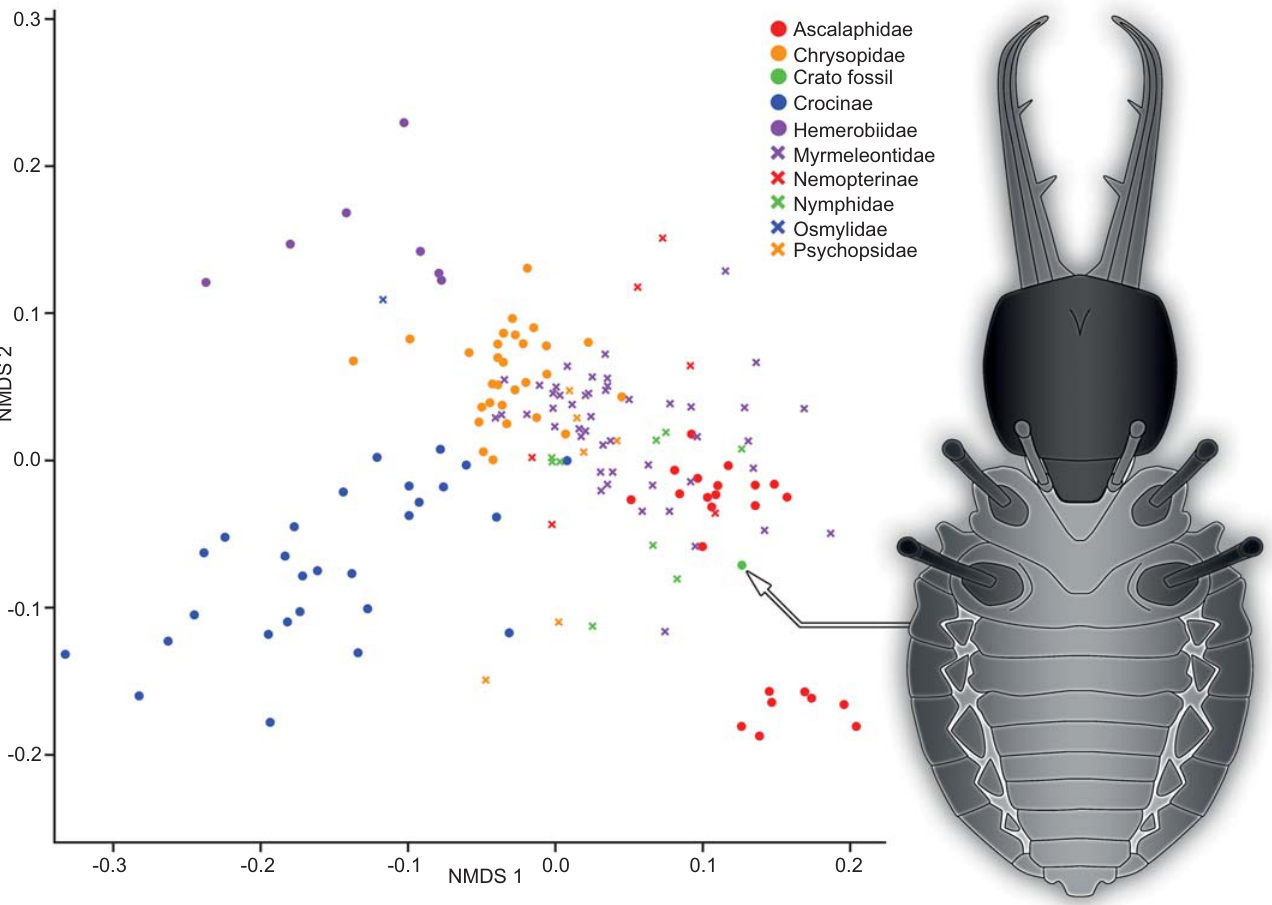
Fig. 4. Non-metric multidimensional scaling (NMDS) plot of measured dimensions. NMDS 1 and 2 are dimensions arbitrarily generated by the model in a way to best represent pairwise dissimilarity between objects (data points). On the right is a simplified restoration of MfN MB.I